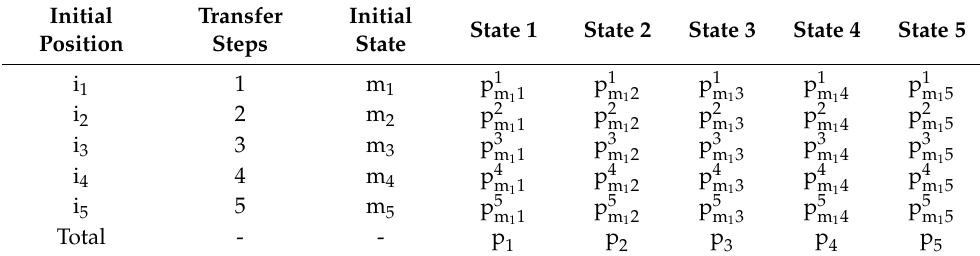
Table 4. State prediction of residual relative